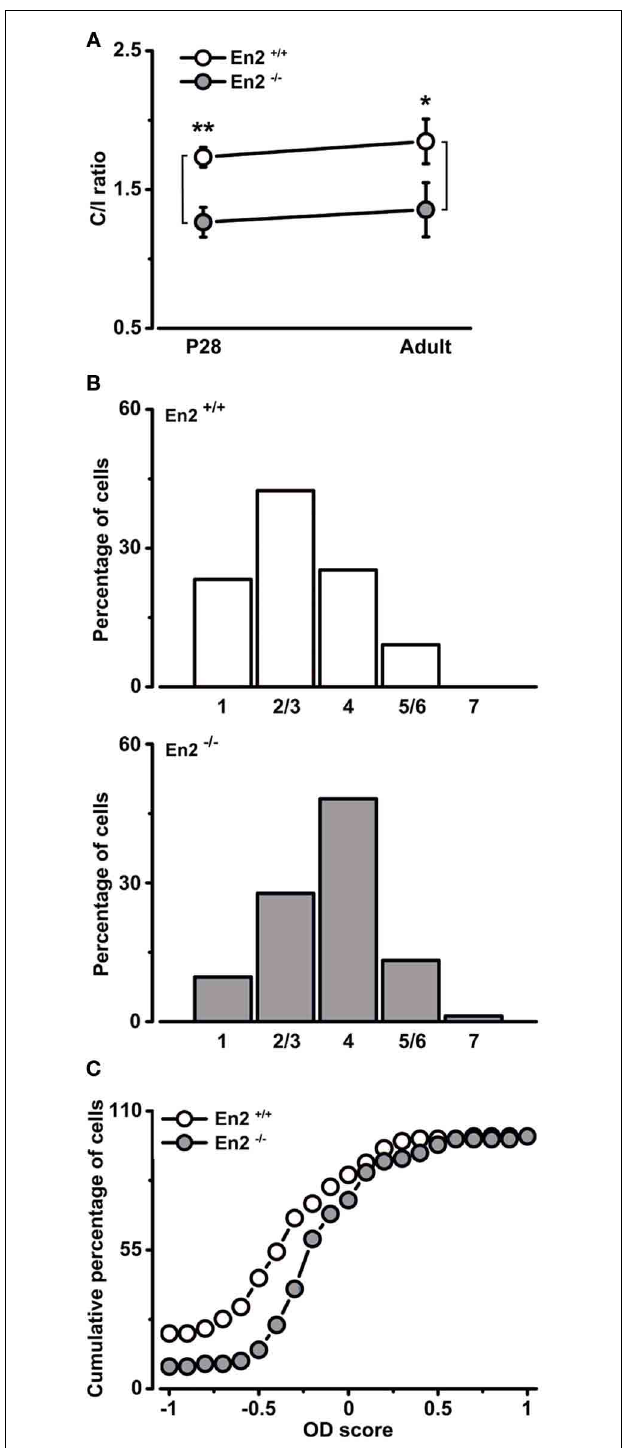
FIGURE 5 | Altered baseline binocularity in primary visual cortex of En2 − / − mice. (A) Baseline binocularity was assessed by measuring the C/I VEP ratio at two different ages, P28 and adult. En2 − / − mice (gray) displayed a lower C/I ratio in comparison to En2 + / + animals (white) at both young and adult ages. The circles depict mean ± s.e.m. (B) OD